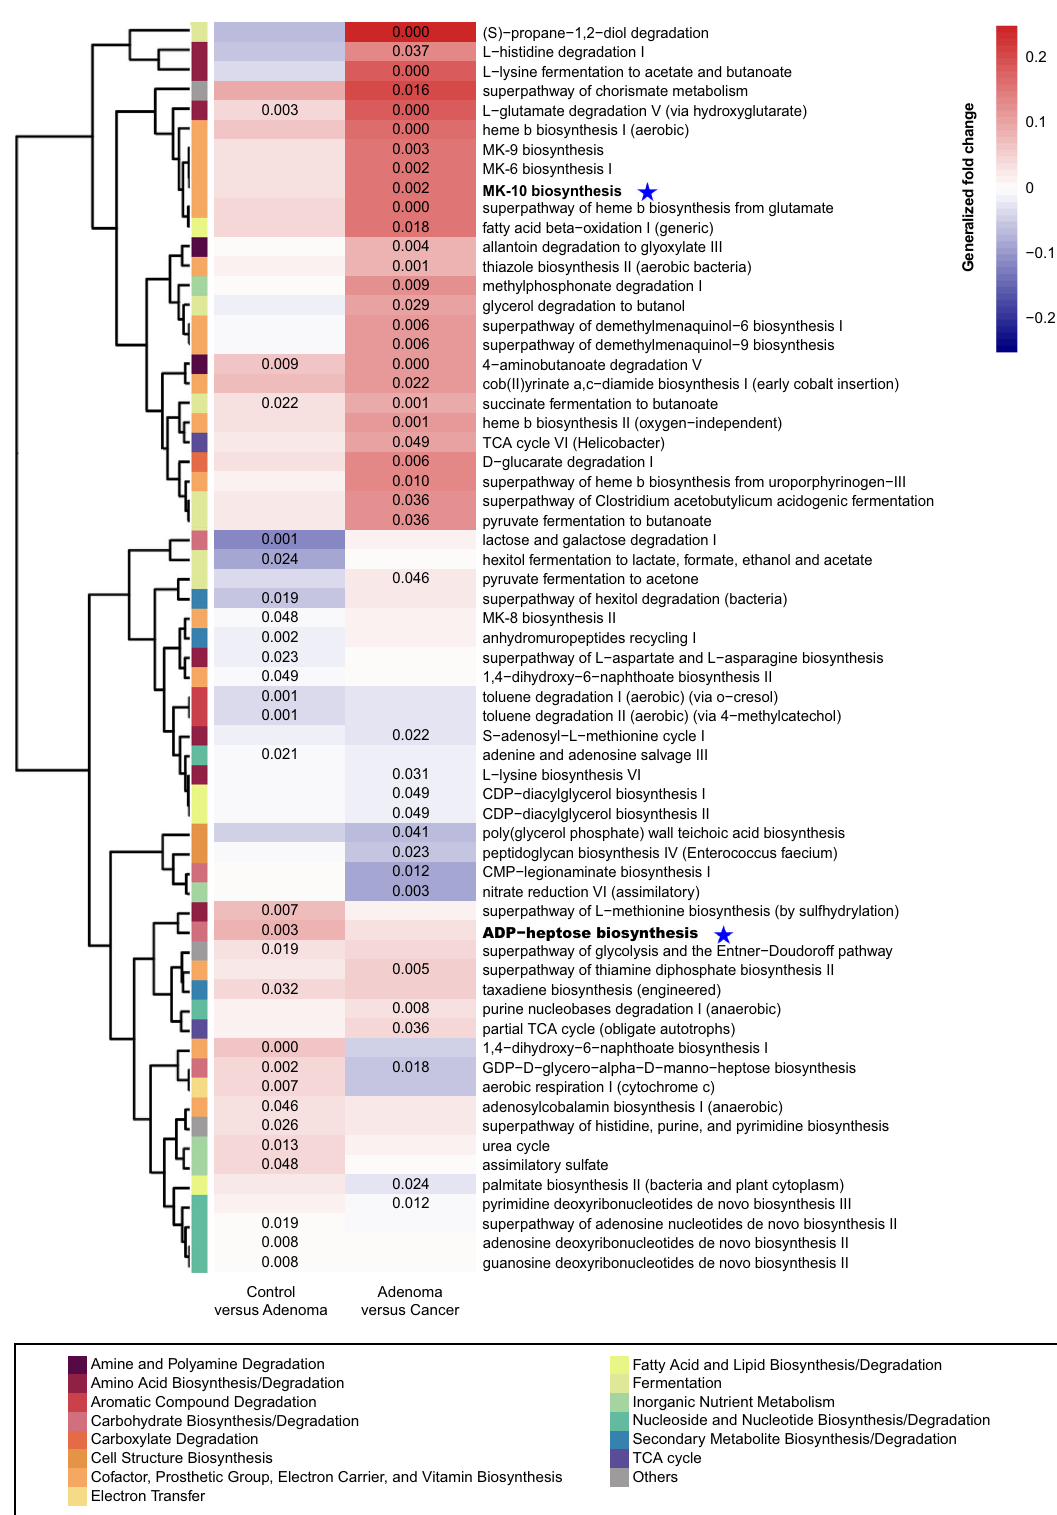
Fig. 4 Functional alterations in control, adenoma, and cancer. The relative abundances of functional pathways were compared between adenoma and control or cancer. Differentially abundant pathways were plotted; P values were computed using a two-sided blocked Wilcoxon rank-sum test and the exact P values < 0.05 were presented in the heatmap. Generalized fold change (see “ Meta-analysis of differentially abundant ASVs ” section) was indicated by color gradients. The generalized fold change> 0: enriched in the latter; generalized fold change < 0: enriched in the former. Source data are provided as a Source Data fi